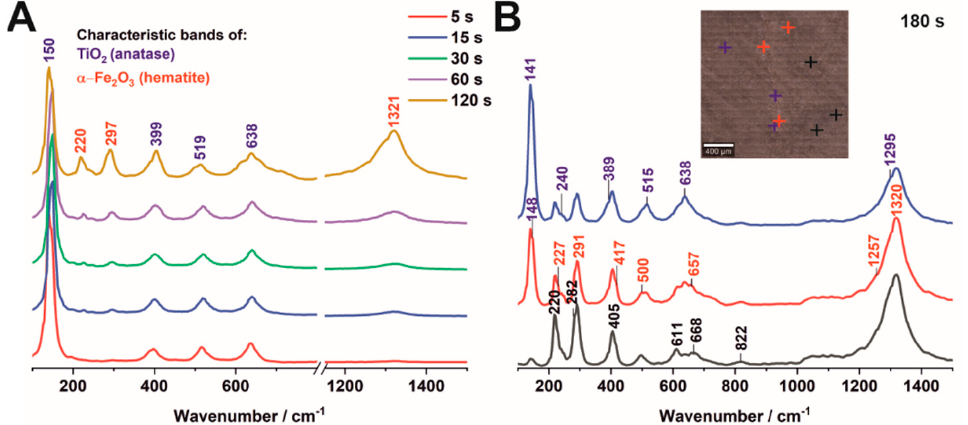
Figure 4. Raman spectra of the Fe 2 O 3 –TiO 2 samples obtained by electrodeposition for 5–120 s ( A ) and 180 s ( B ). The colors of different areas on the picture correspond to the colors of the Raman spectra.